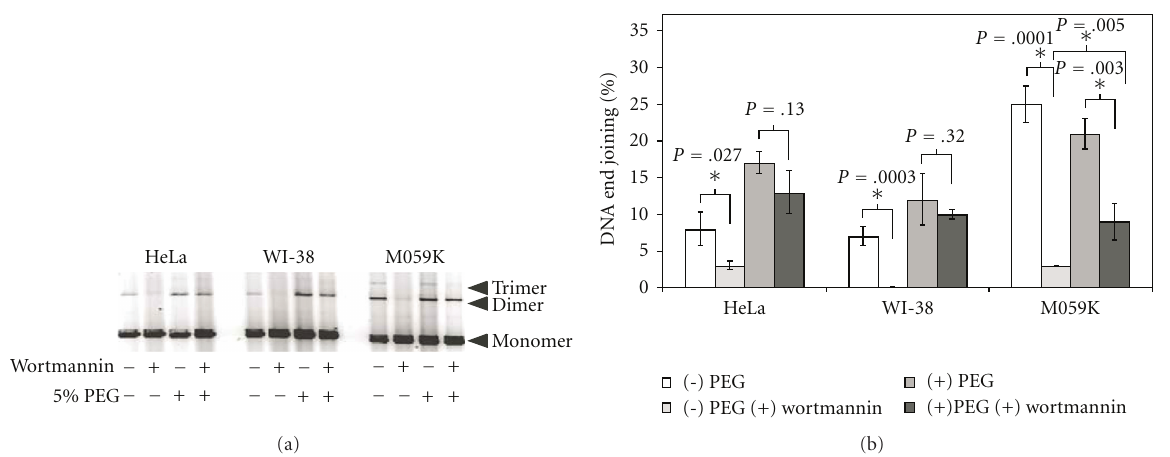
Figure 1: DNA end joining with HeLa, WI-38, and M059K WCEs with and without 5% PEG and/or 10 μ M wortmannin. (a) Agarose gel image showing typical DNA end-joining reaction results. Dimer and trimer DNA end-joining product yields are calculated as a fraction of the total DNA in the lane and reported graphically as shown in panel B. (b) Graphical depiction of results for triplicate end-joining reactions run with the three cell extracts under each of the conditions indicated. Error bars indicate the standard deviation for triplicate reactions. Significant di ff erences, as determined by the Student t -test, are indicated by an asterisk. The P -values for each pairing are given above the